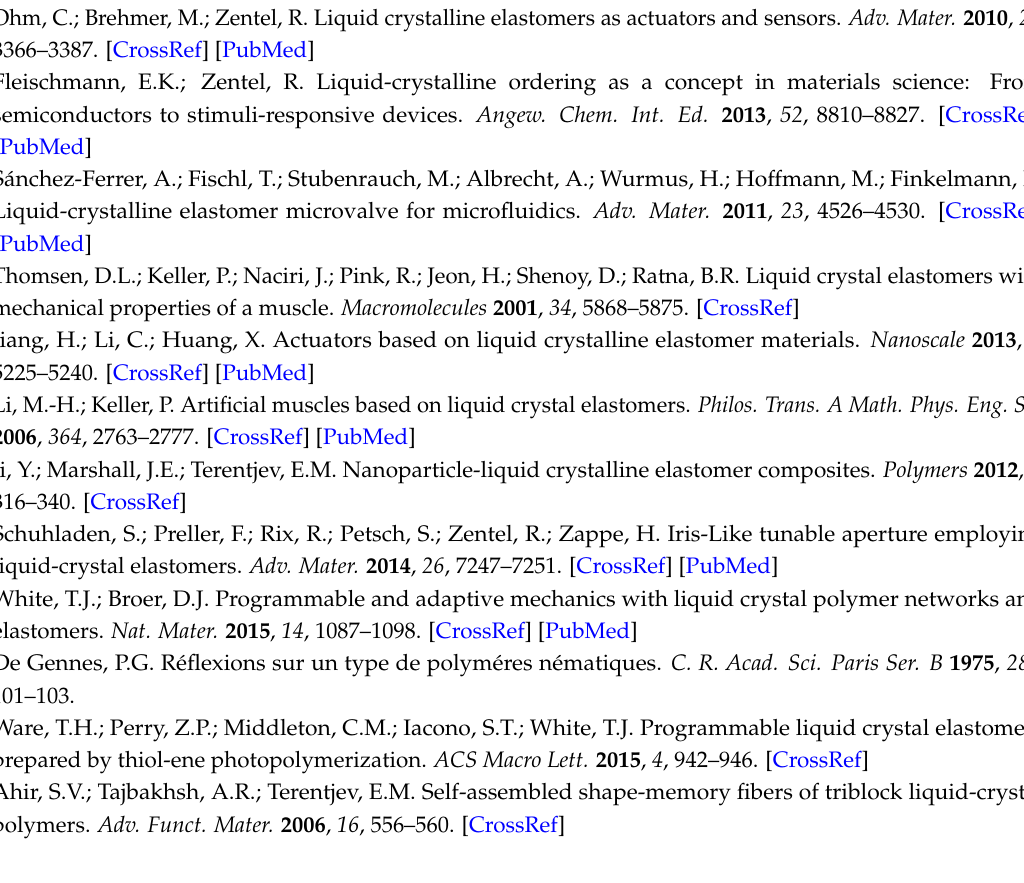
Figure S1: Transmission spectrum of the red light filter OG 590 (Schott), Figure S2: UV–vis spectra of the monomer before irradiation and after irradiation with the white light LED as well as with UV light, Figure 3: UV–vis spectra of the crosslinker before irradiation and after irradiation with the white light LED as well as with UV light; Video S1: Photoactuation of an LCE film at 70 ◦ C during irradiation with a white cold light lamp